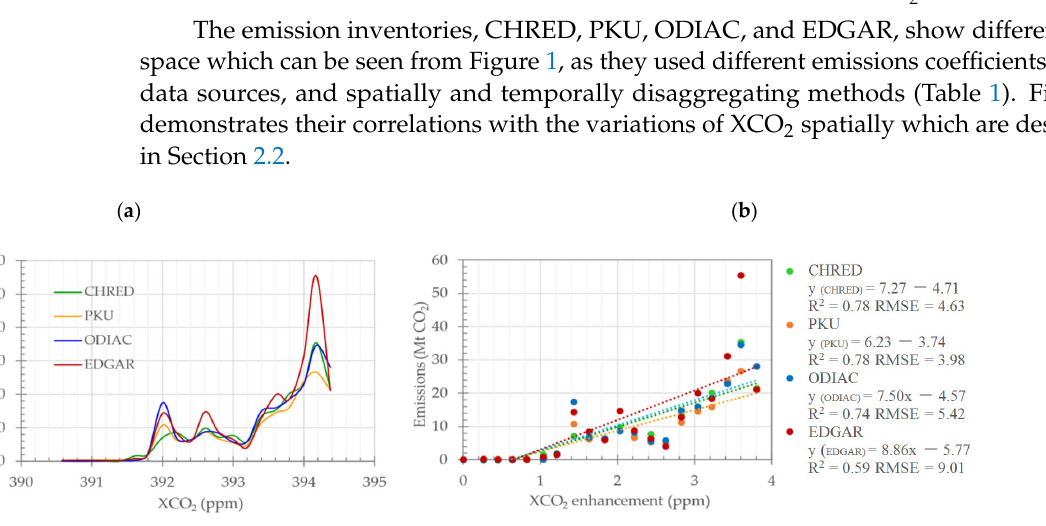
Figure 2. Correlation between emissions from bottom-up inventories and XCO 2 from satellites in 2012. ( a ) Averaged emissions corresponding to different XCO 2 in each segment of XCO 2 ; ( b ) Correlation between bottom-up inventory emissions and satellite-observed XCO 2 enhancement.